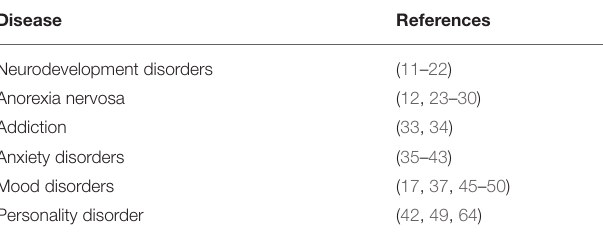
TABLE 1 | Neuropsychiatric disorders associated with EDS.